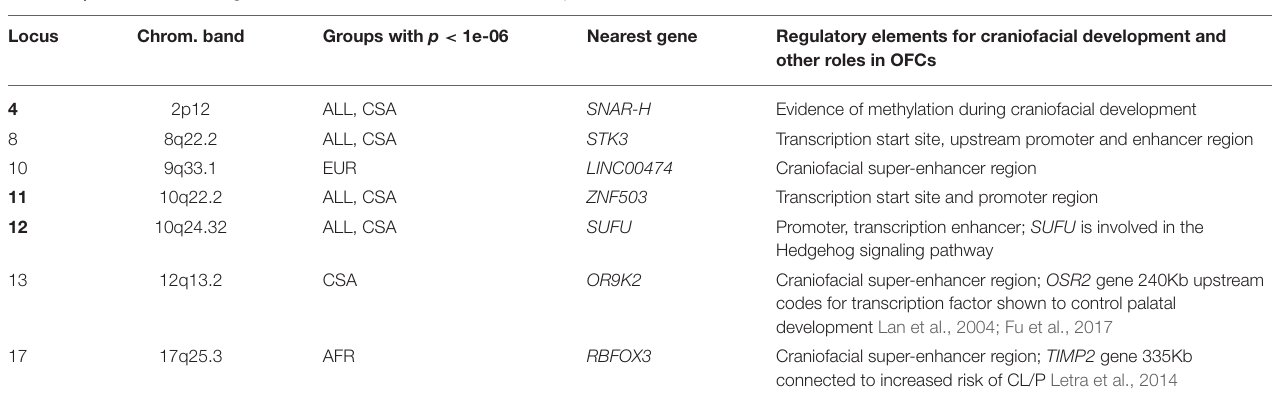
TABLE 3 | Novel loci, closest gene, and contribution to craniofacial development. Locus Chrom. band Groups with p < 1e-06 Nearest gene Regulatory elements for craniofacial development and